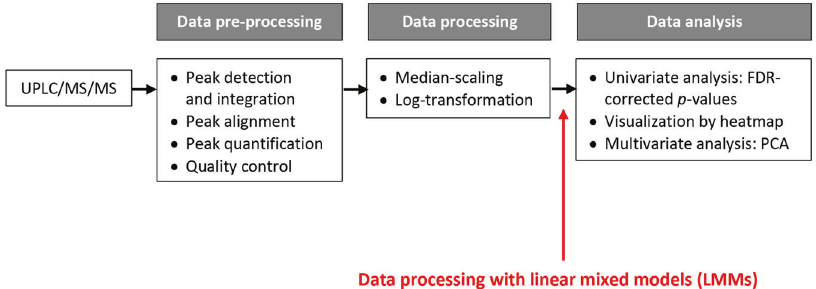
Fig. 2 Fecal metabolomics data analysis work fl ow. The acquisition of raw data from the ultra-performance liquid chromatography-tandem mass spectrometry (UPLC/MS/MS) platform was followed by two steps to generate “ clean ” data to be used as the input for the statistical analysis (FDR-corrected p values, principal component analysis, [PCA]) and biological interpretation: data pre-processing, which included peak alignment and quanti fi cation, and data processing, which consisted of scaling and normalization by log-transformation. In our study, the linear mixed models (LMM) method (in red) is proposed as an additional step performed after the conventional data processing tasks.